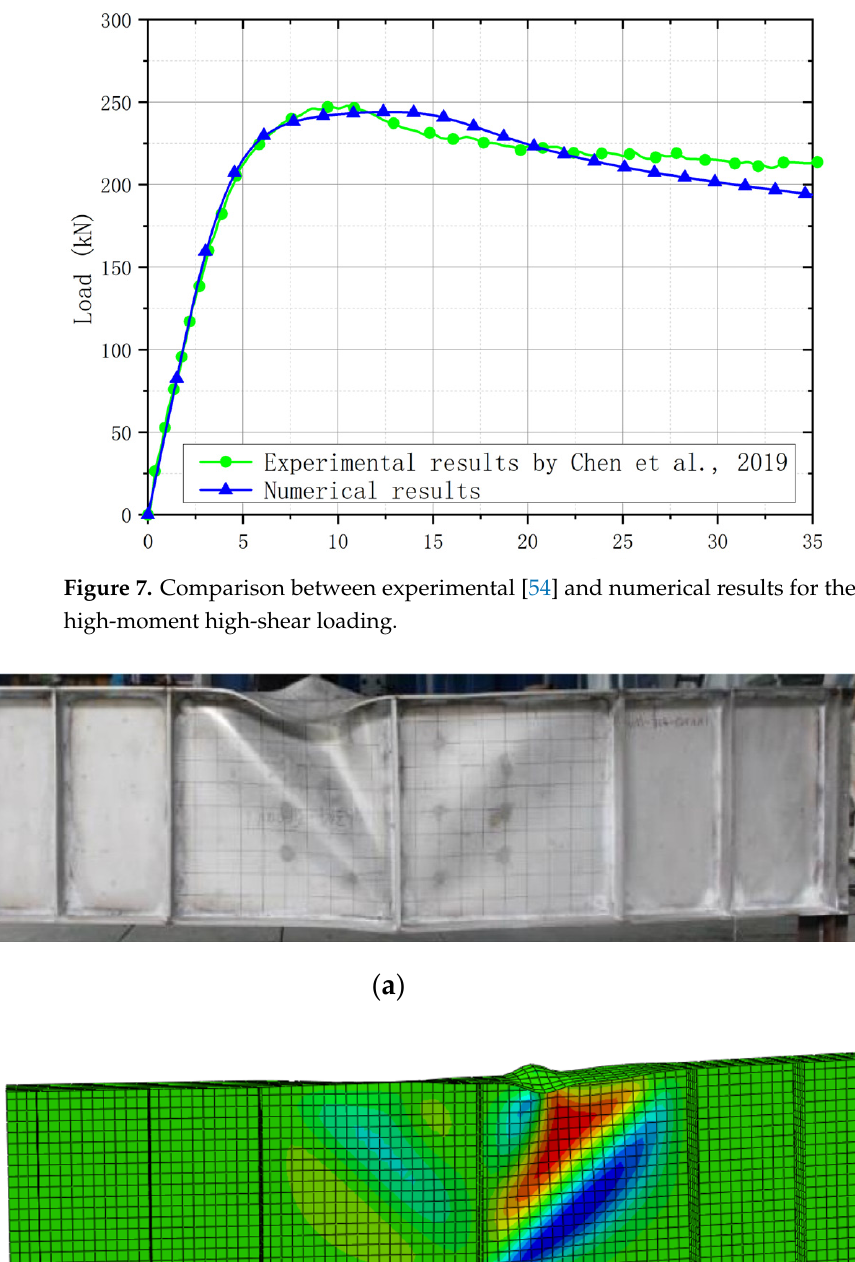
Figure 6. Comparison between experimental [31] and numerical results for plate girder under low- moment high-shear loading.